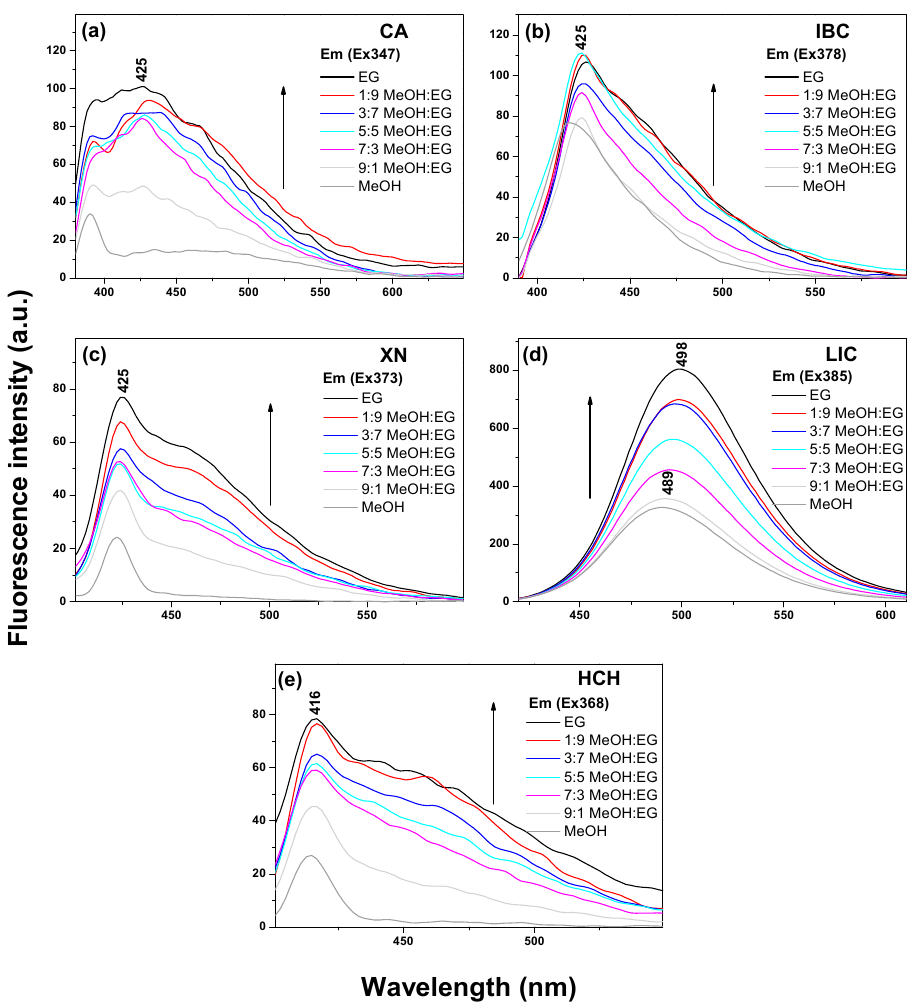
Figure 4. Fluorescence emission spectra of chalcones in the MeOH:ethylene glycol system. ( a ) CA Em (Ex 347), ( b ) IBC Em (Ex 378), ( c ) XN Em (Ex 373), ( d ) LIC Em (Ex 385) and ( e ) HCH Em (Ex